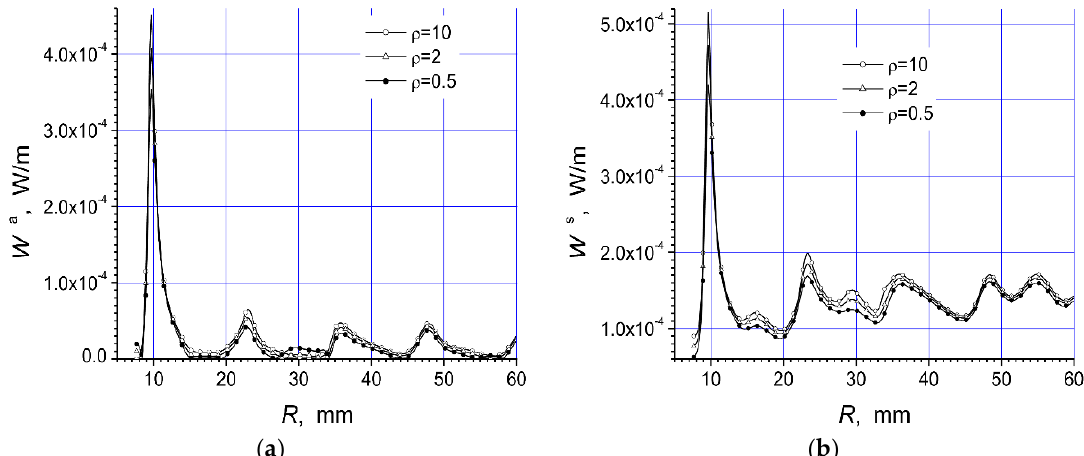
Figure 4. Dependencies of absorbed power ( a ) and scattered power ( b ), of the array Figure 1a, on the arc radius R at the parallel polarized incident wave with f = 12 GHz.